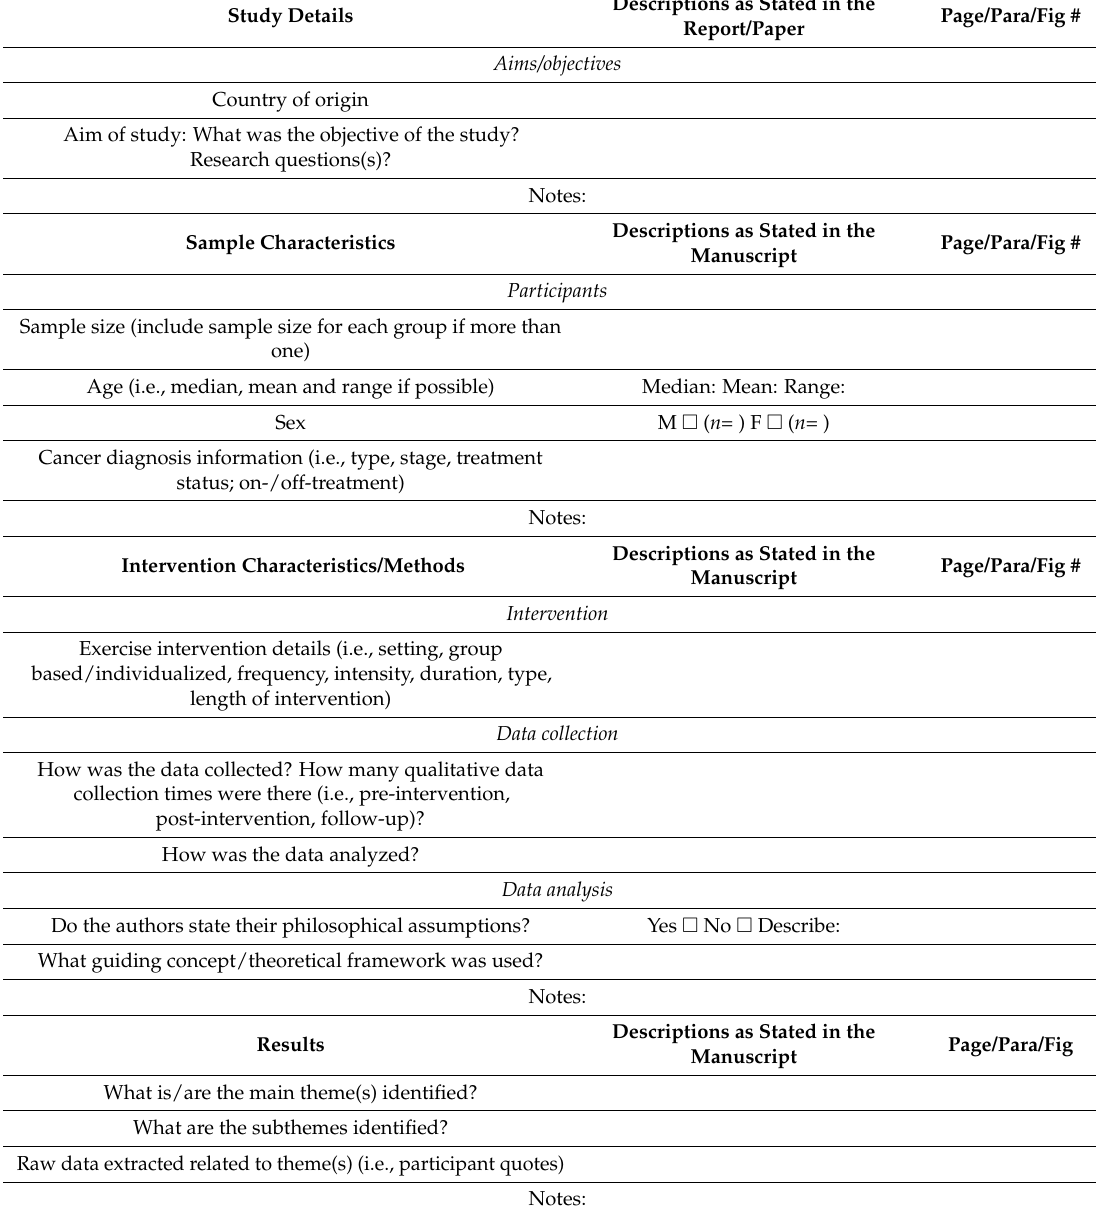
Table A2. Data Extraction